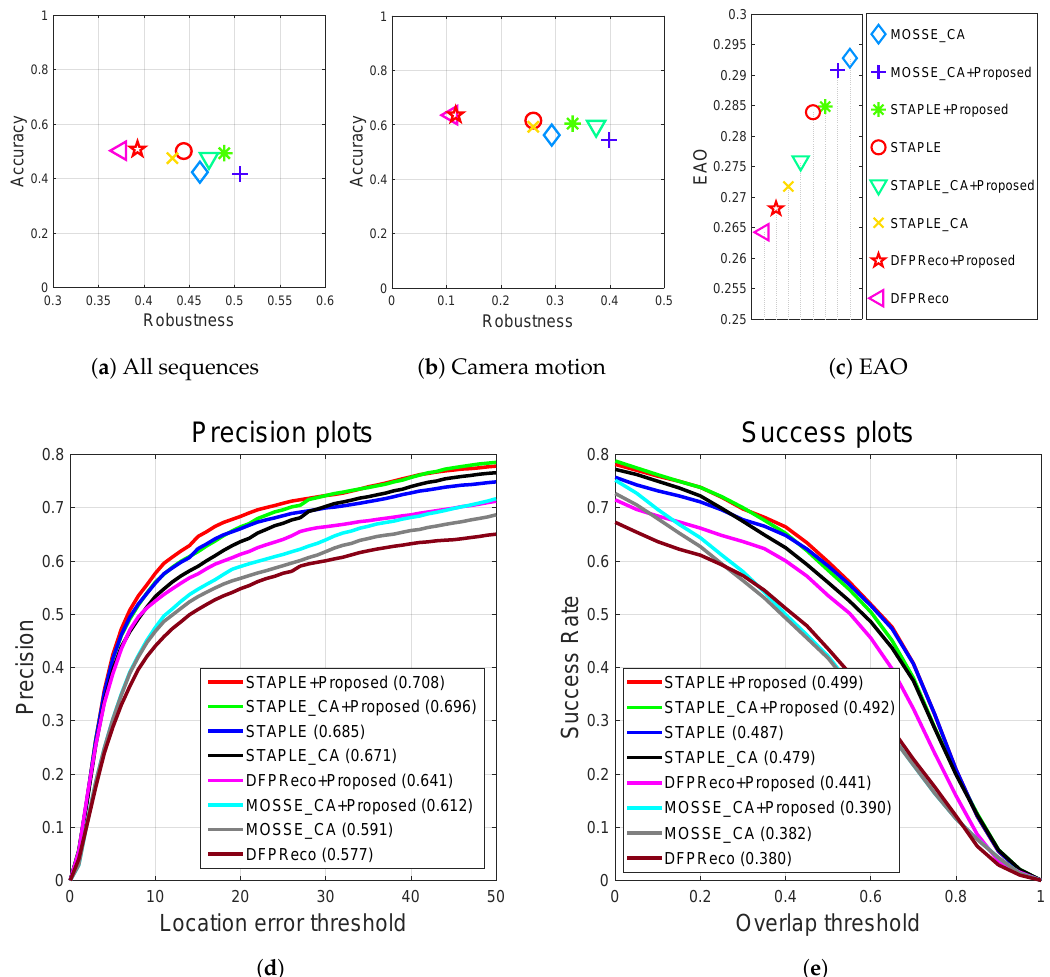
Figure 8. Results of the experimental validation on the Visual Object Tracking Challenge in 2019 (VOT2019)-RGB-TIR datasets. ( a ) An evaluation of the accuracy and robustness for the VOT evaluation, ( b ) the accuracy and robustness under camera motion for the VOT evaluation, ( c ) the expected average overlap (EAO) of the compared trackers for the VOT evaluation, ( d ) the precision plots of the one pass evaluation (OPE) result, and ( e ) the success plots of the OPE